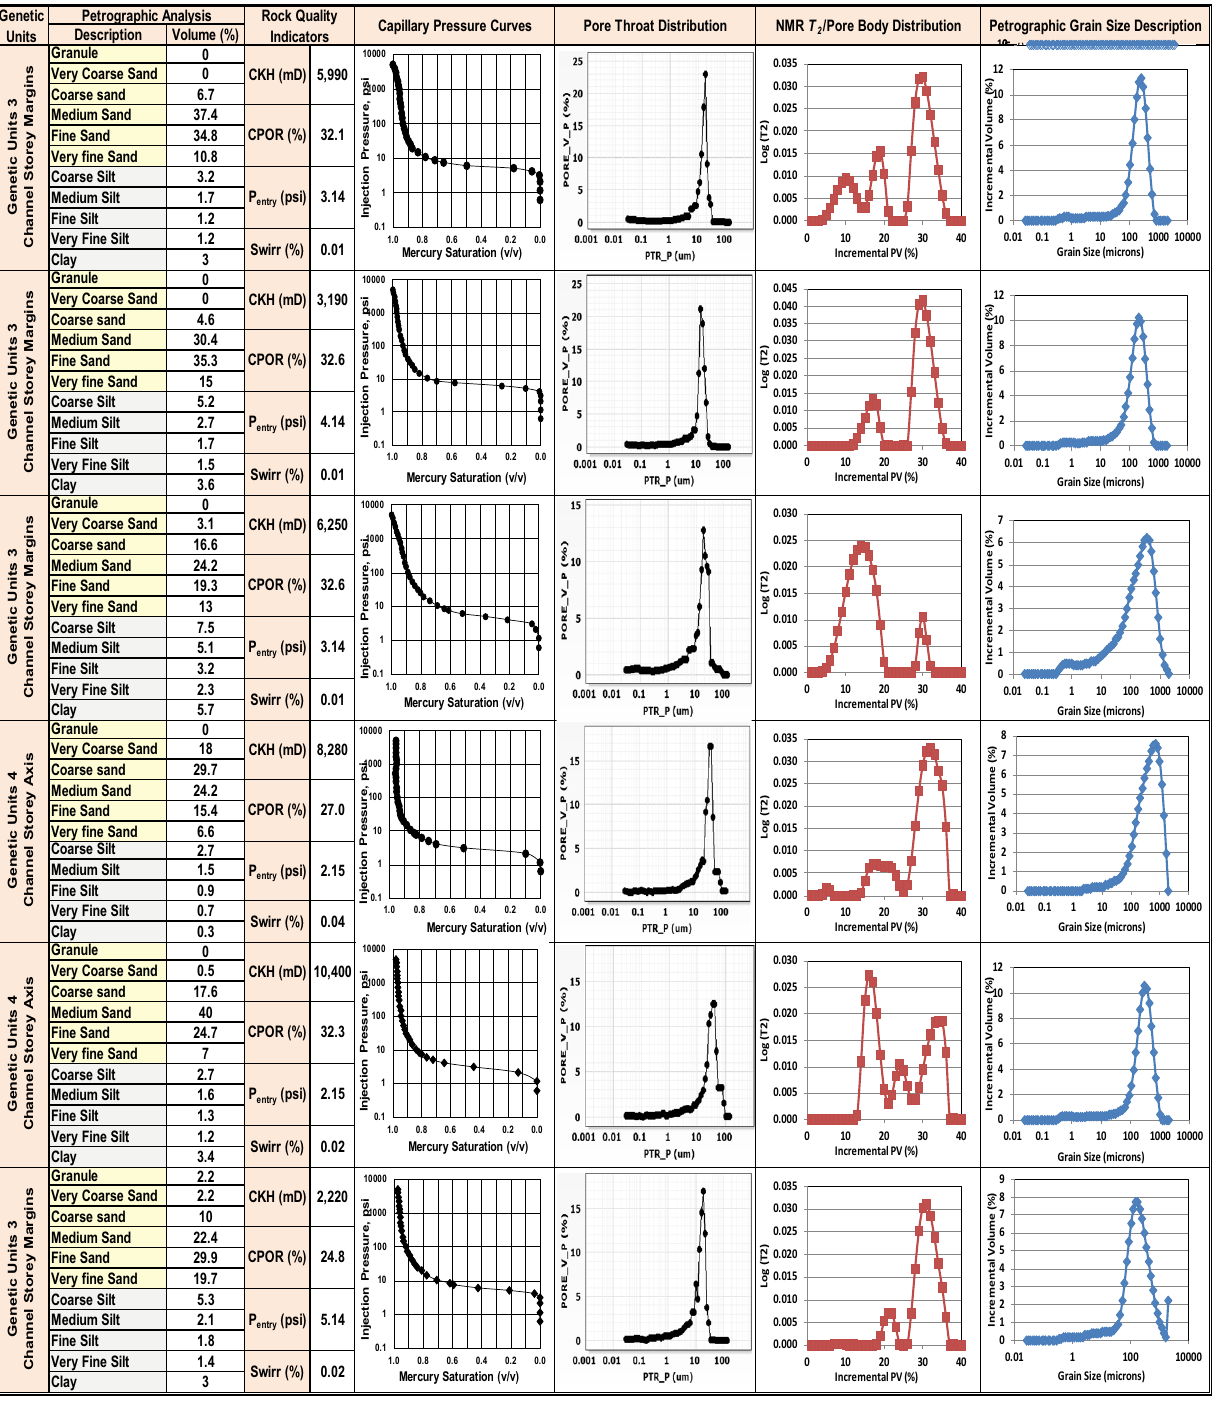
pore bodies and pore throats for various genetic reservoir units, within the Deep Water Niger